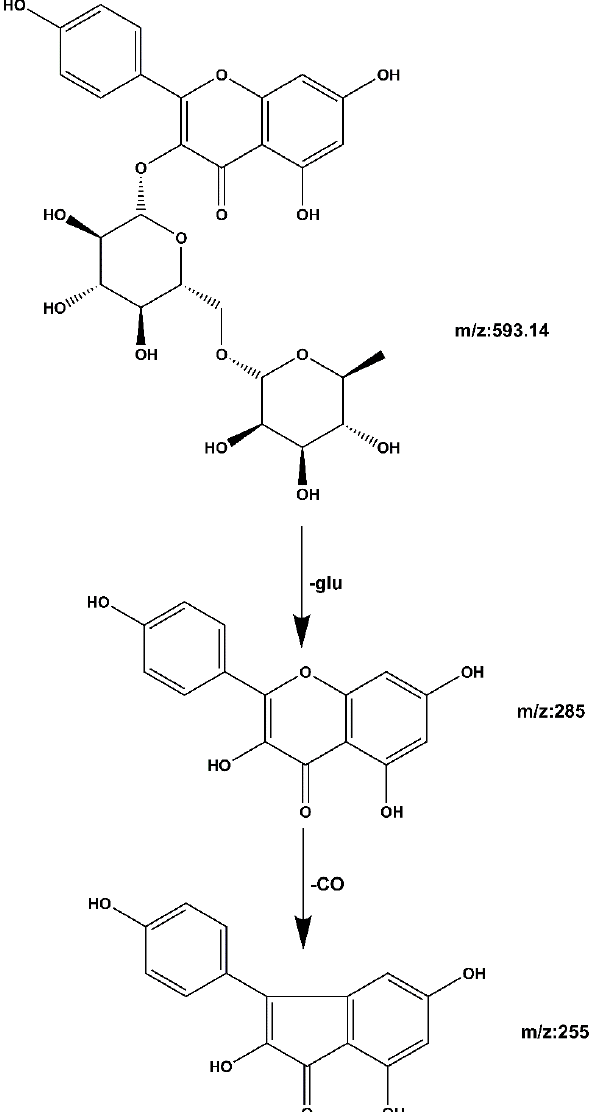
Molecules 2022 , 27 , x FOR PEER REVIEW Figure 8. Kaempferol 3-o-rutinoside mass spectrometric cleavage pathway Figure 8. Kaempferol 3-o-rutinoside mass spectrometric cleavage pathway. Compound 3 Gallic acid: The quasi-molecular ion peak is shown at [M − H] − m / z 169, and the chromatographic retention time is 2.16 min. While m / z 125 is the ion peak of miss- ing – COOH. The cracking process is shown in Figure 9. Compared with the literature [27,30], it is inferred that the compound is gallic acid.